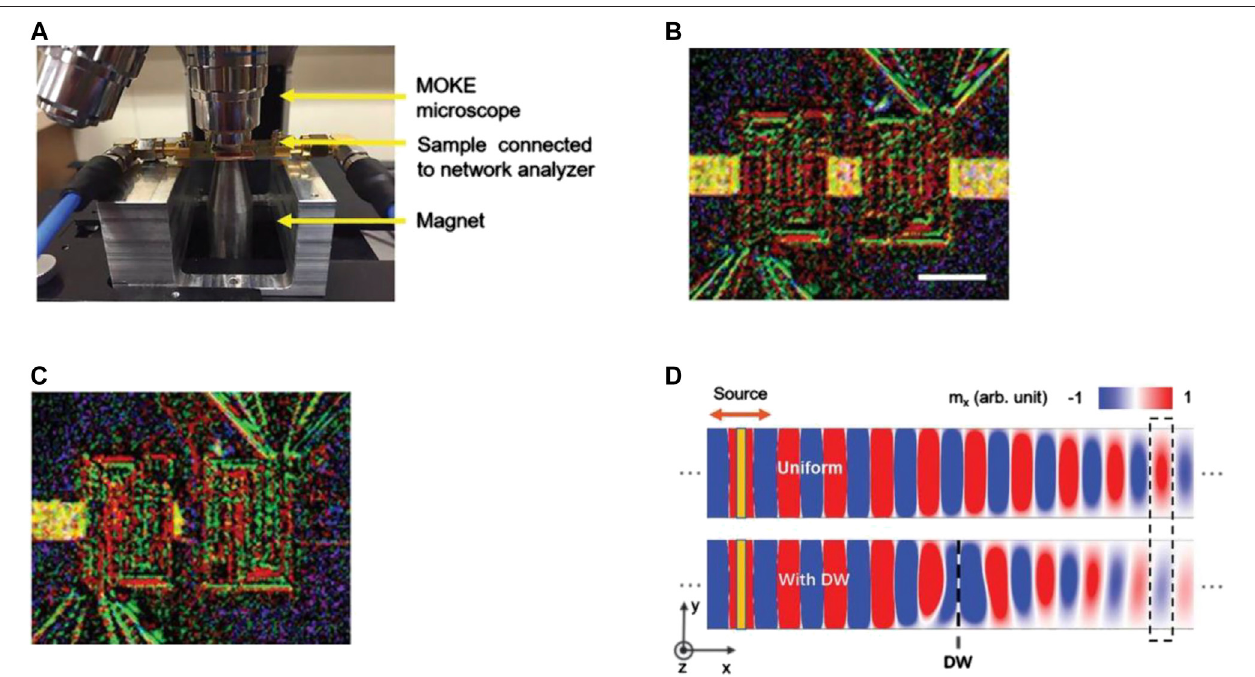
FIGURE 10 | (A) Experimental setup for controlling the phase and amplitude of spin waves by a domain wall (Han et al., 2019). (B), (C) Magneto-optic Kerr effect (MOKE) images. The lightand dark colors represent domains with opposite magnetizationdirections. In (B) the waveguideisuniform,and in (C) there isa domain wall in the middle of the waveguide. (D) Simulation diagram of spin-wave propagation. The upper and lower waveguides correspond to (B) uniform state and (C) domain wall state, respectively. The single dotted line indicates an inserted domain wall and the dotted rectangular indicates a phase shifting of nearly 180 ° after spin-wave passes through the domain wall. (A – D) Reprinted with permission from Han, J., Zhang, P., Hou, J.T., Siddiqui, S.A., and Liu, L. (2019). Mutual control of coherent spin waves and magnetic domain walls in a magnonic device. Science 366 (6469), 1121 – 1125. Copyright 2019 American Association for the Advancement of